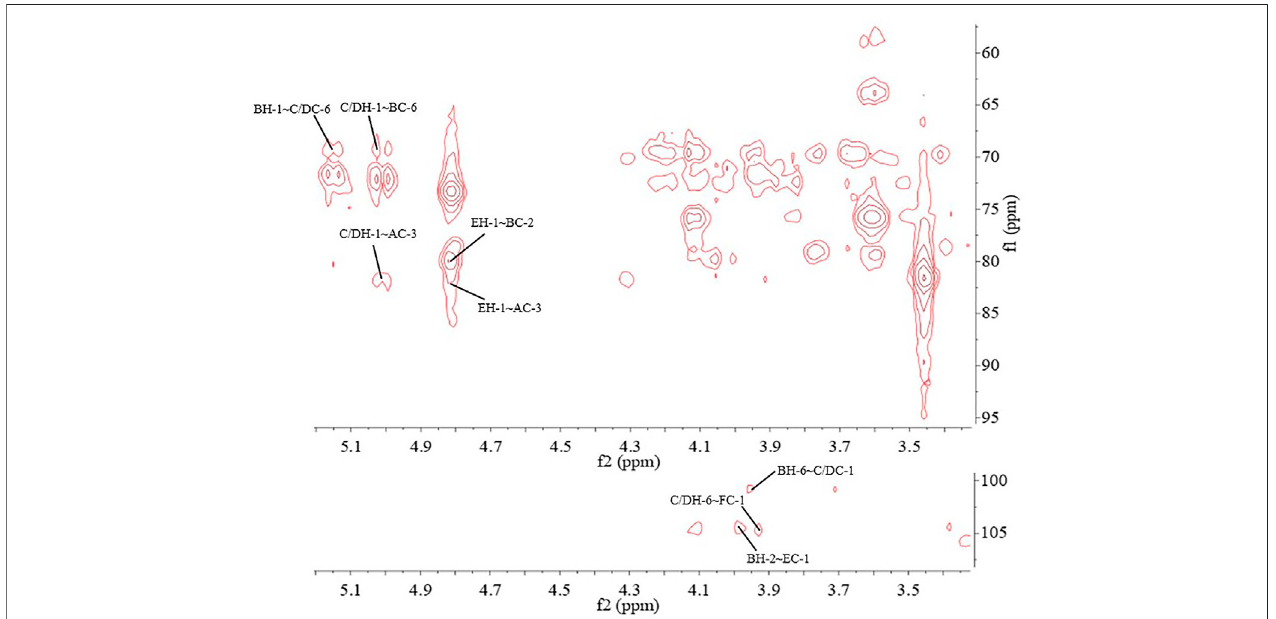
TABLE 3 | Two-and three-bond 1 H – 13 C correlations for the PPp-W in the HMBC spectrum. Residue Proton Proton correlation a → 3)- α -D-Glc p -(1 → (A)